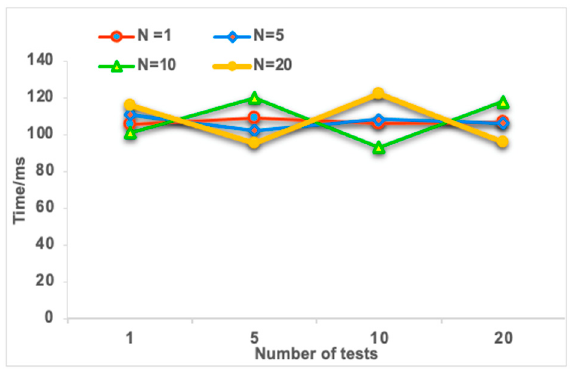
Figure 5. Analysis of on-chain certificate storage performance.